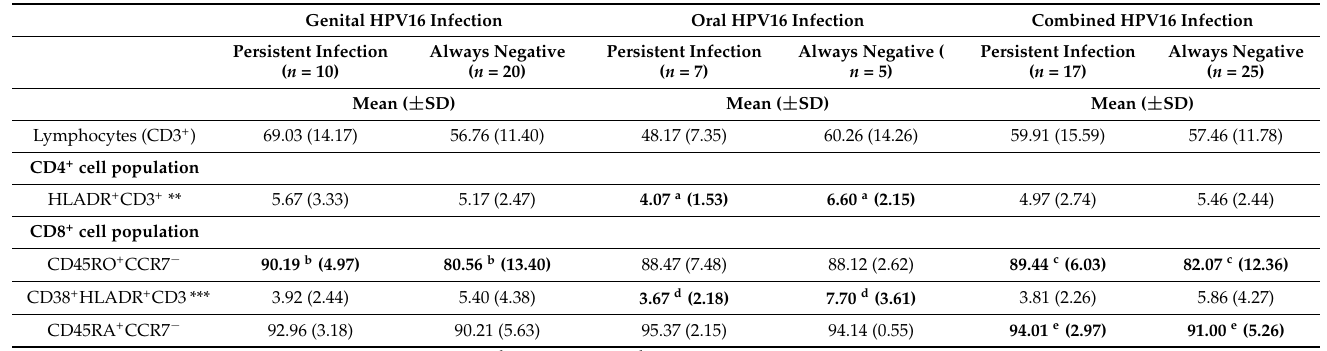
Table 5. The proportion of CD4 + or CD8 + lymphocytes by their immunophenotypic subsets * given as mean ( ± SD) percentages among the mothers with persistent genital or oral HPV16 HPV- negative mothers. Only lymphocyte subsets with statistically significant differences are given, results are